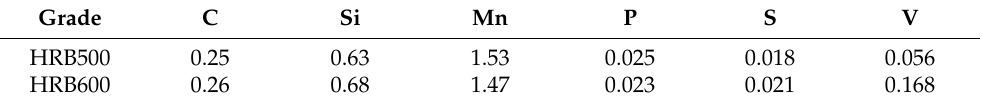
Table 1. Chemical composition of HRB500 and HRB600 hot-rolled ribbed steel bars. Grade